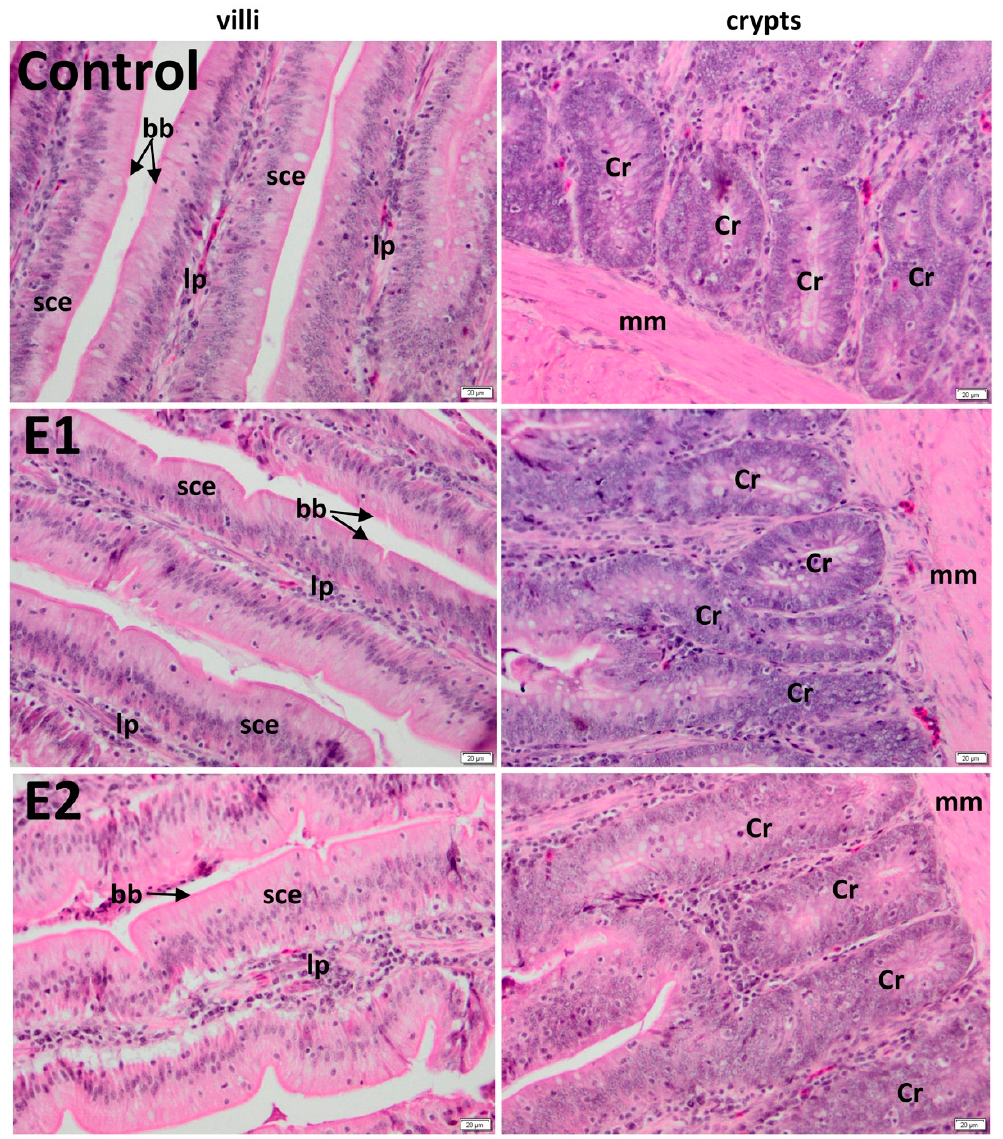
Figure 1. Effect of bilberry and walnut leaves supplementation diet on duodenum morphology of laying hens: The basal diet served as the control, and different levels of herbal feed additives were supplemented to the basal diet as follows: 0.5% cranberry leaves (E1) and 1% walnut leaves (E2). Sce: simple columnar epithelium; lp: lamina propria; cr: crypt; mm: muscularis mucosa. bb: brush border; H&E (Hematoxylin and Eosin) stain; (n = 10); n: number of replicates.